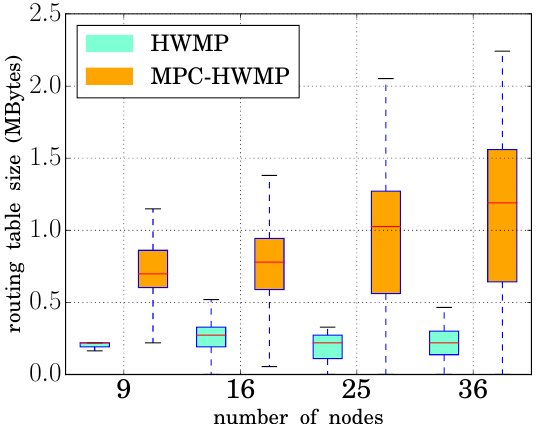
Figure 10. Routing table size (HWMP vs.